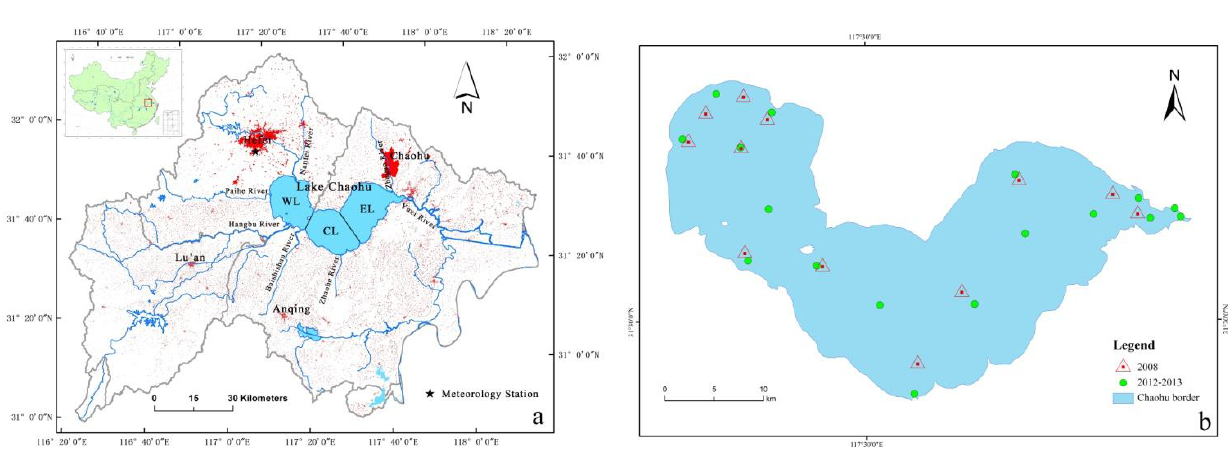
Figure 1. ( a ) Lake Chaohu, China, (source: 1:250,000 basic geographic information data provided by the National Administration of Surveying, Mapping, and Geo-information of China) and the three lake segments, West Lake (WL), Central Lake (CL), and East Lake (EL). The red areas represent major cities. ( b ) Sampling sites of measurements made in 2008, 2012, and 2013 in Lake